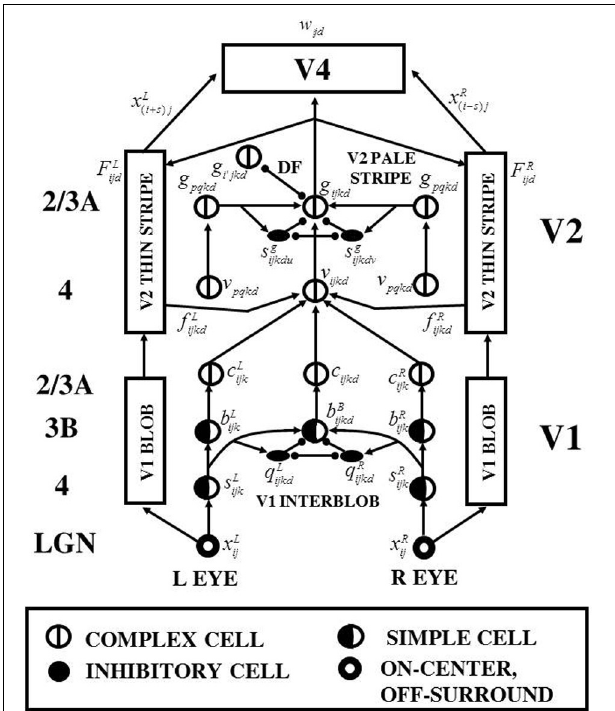
FIGURE 1 | 3D LAMINART model variables, circuits, and processing stages. The model consists of interactions between a boundary cortical stream and a surface cortical stream. The boundary stream computes 3D perceptual groupings. Its processing stages are in the middle of the figure, and go through the cortical areas (V1 Interblob)—(V2 Pale Stripe)—V4. The surface stream computes 3D surface representations of lightness, color, and depth. Its processing stages flank those of the boundary stream on both the left and right, and go through the cortical areas (V1 Blob)—(V2 Thin Stripe)—V4. The cortical layers in which the various processes are hypothesized to take place are listed in the left column of the figure. The mathematical variables of the various model processing stages provide a visualization of the network dynamics that are mathematically defined in Section 4. Adapted with permission from Cao and Grossberg